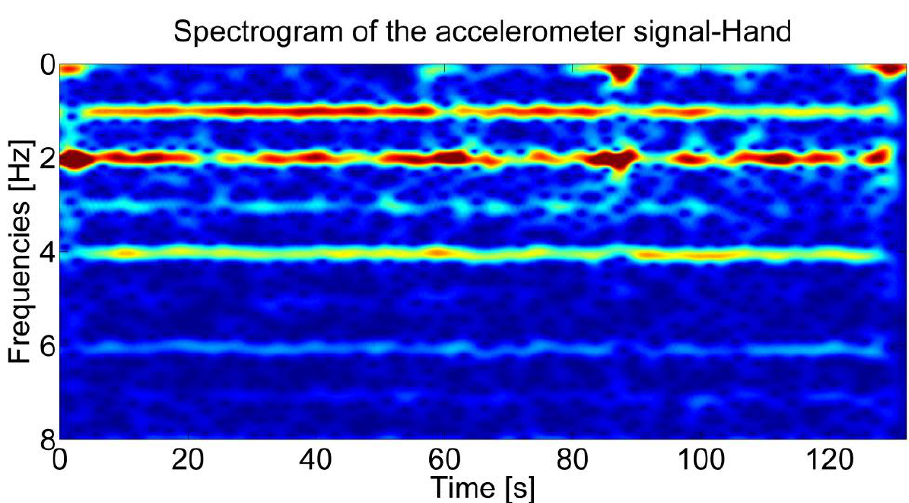
Figure 2. Spectrogram of the accelerometer signal for the sensor placed in the walking user’s swinging